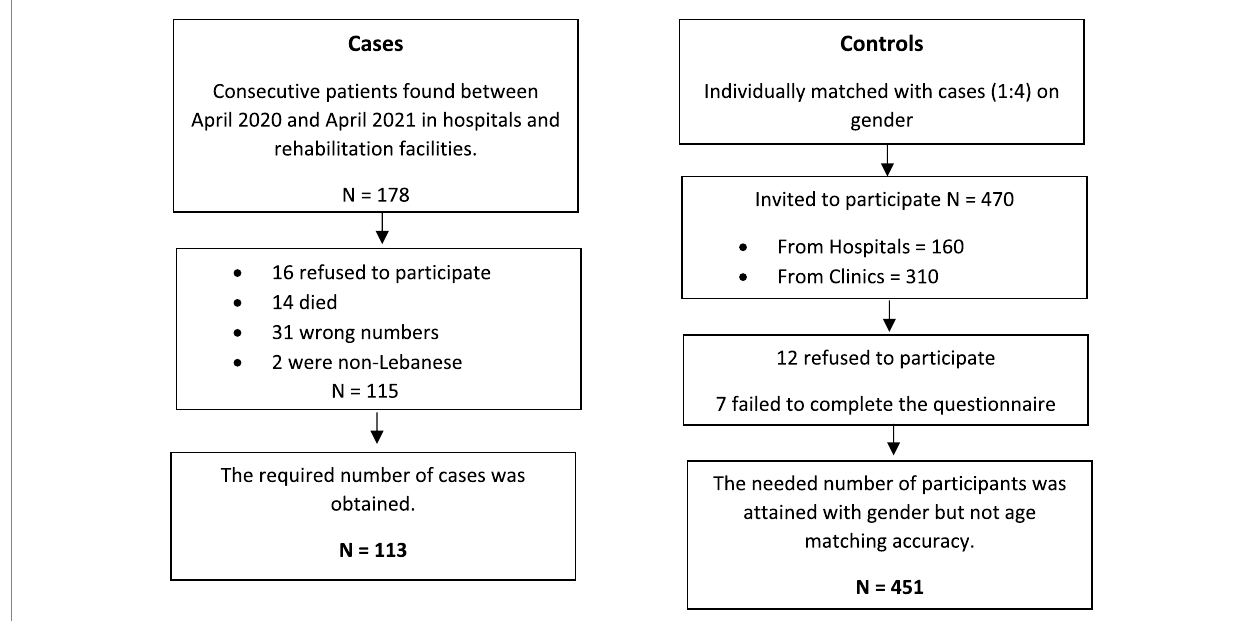
FIGURE 1 Participants’ flowchart showing cases of ischemic stroke and matched